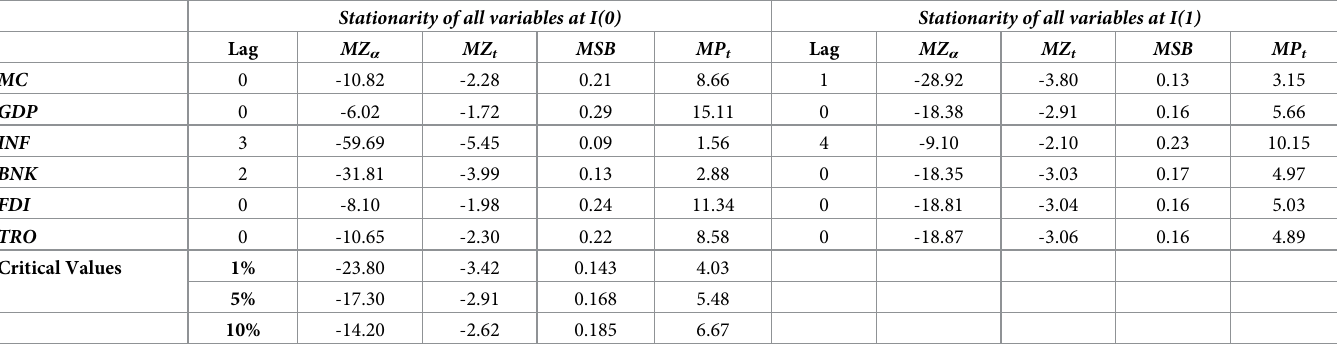
Table 2. Ng-Perron unit root test results.